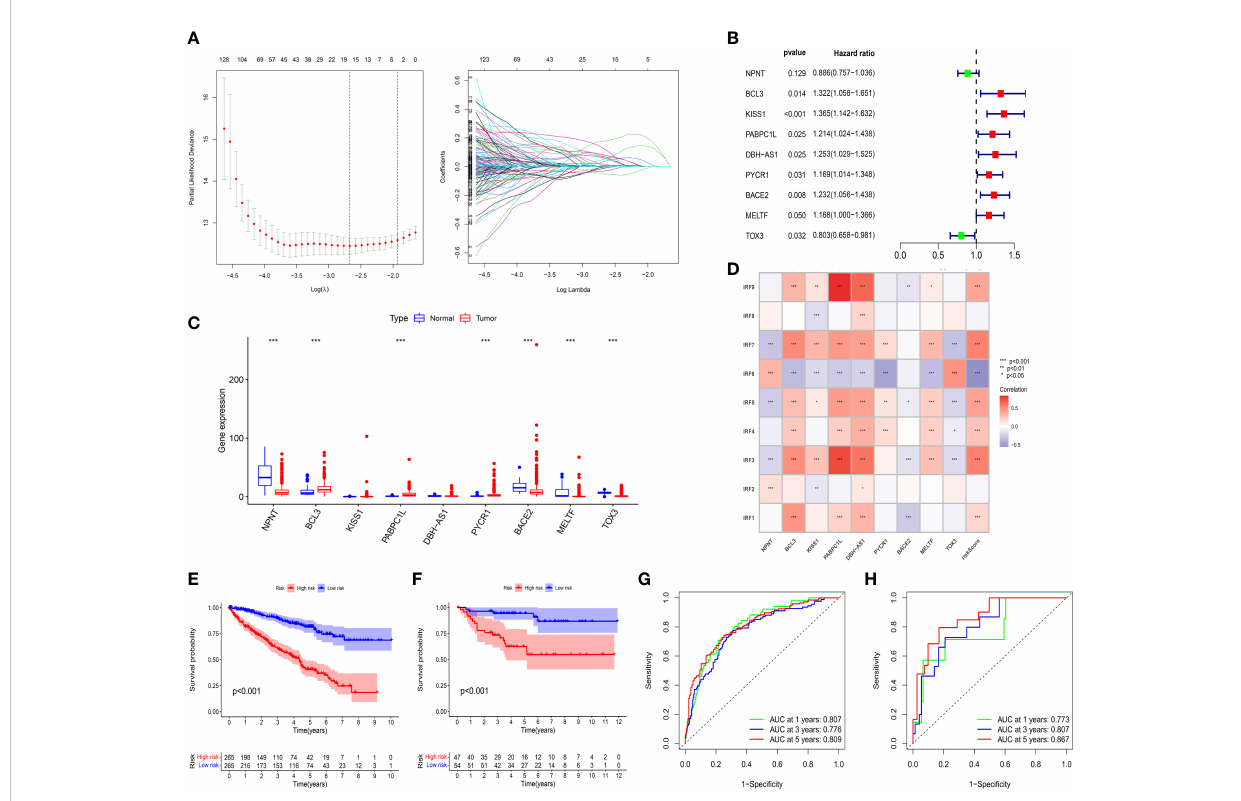
FIGURE 5 Construction and validation of an IRFs-related prognostic model. (A) The LASSO Cox regression analysis was performed to fi lter out the candidate genes. (B) 9 genes were retained to construct a prognostic model using the multivariate Cox regression analysis. (C) The mRNA expression levels of the nine genes between ccRCC samples and normal samples in the TCGA-KIRC dataset. (D) Correlations between IRF family members and risk score. (E, F) KM curves of OS between the low- and high-risk groups in TCGA-KIRC and E-MTAB-1980 datasets. (G, H) ROC curves of the IRFs- related prognostic model in predicting the 1-, 3- and 5-year OS in the TCGA-KIRC and E-MTAB-1980 datasets. * p <0.05, ** p <0.01, *** p